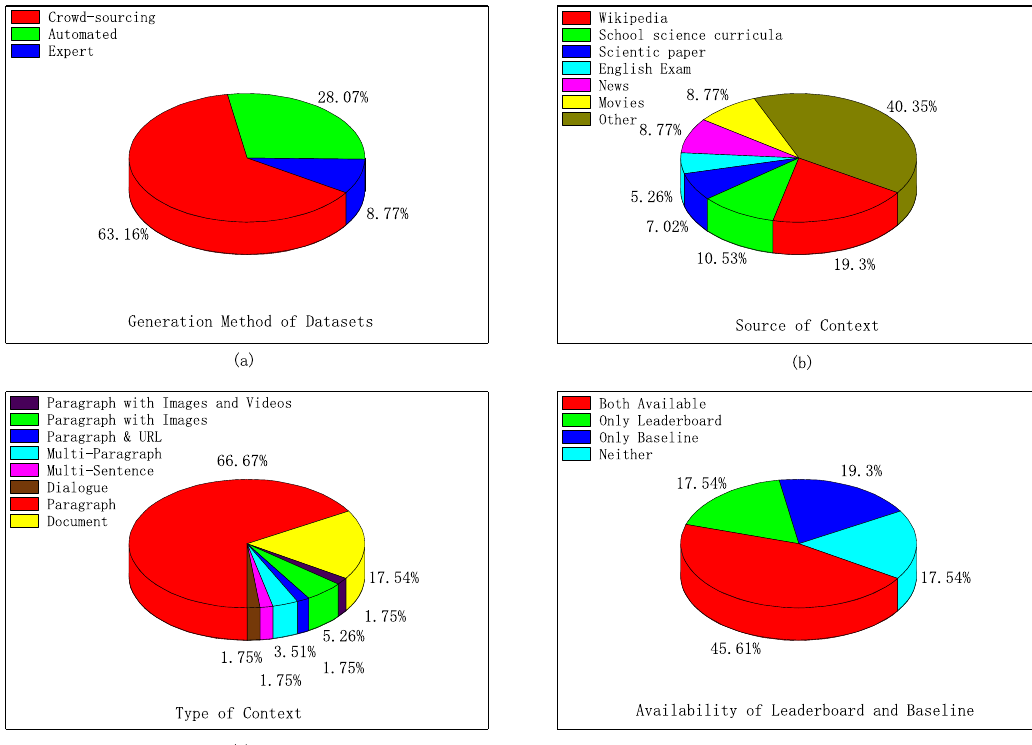
Figure 23. Statistical analysis of the datasets: ( a ) The generation method of datasets. ( b ) The source of corpus. ( c ) The type of context. ( d ) The availability of leaderboards and baselines.